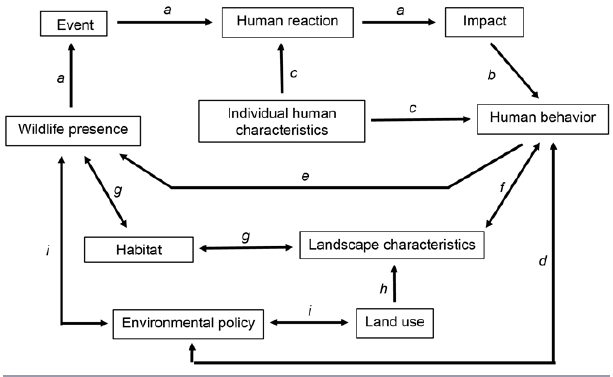
Fig. 1 . Conceptual framework for evaluating human-wildlife interactions and feedbacks in a coupled human and natural system. Arrows indicate unidirectional (single arrows) and bidirectional (double arrows) interactions and feedbacks between system components and characteristics. Relationships described in the text are as follows: (a) a wildlife related event plus a human reaction results in an impact; (b) impacts can influence human behavior; (c) individual human characteristics can influence reactions and behaviors; (d) human behaviors serve as drivers of wildlife management and policy; (e) human behavior resulting in an impact could have direct and (f) indirect feedbacks that affect wildlife; (g) changes to the landscape as a result of human behaviors occur across multiple scales; (h) land use affects landscape characteristics; (i) environmental policy limits human behavior for the benefit of humans and other species. Letters a-d correspond to impact- based feedbacks. Letters e-g correspond to behavior-based feedbacks. Letters g-i correspond to landscape-based feedbacks. Letters a-c and g-h correspond to components and feedbacks traditionally considered parts of the “human system” and “natural system,” respectively, with d-f and i representing linkages between